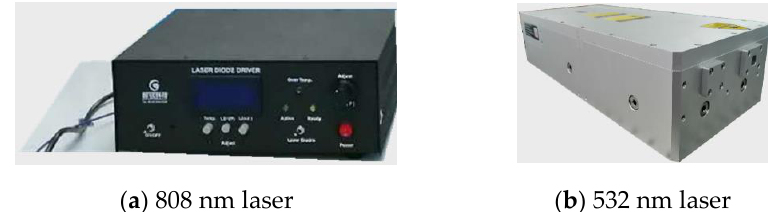
Figure 10. The laser in the experiment.